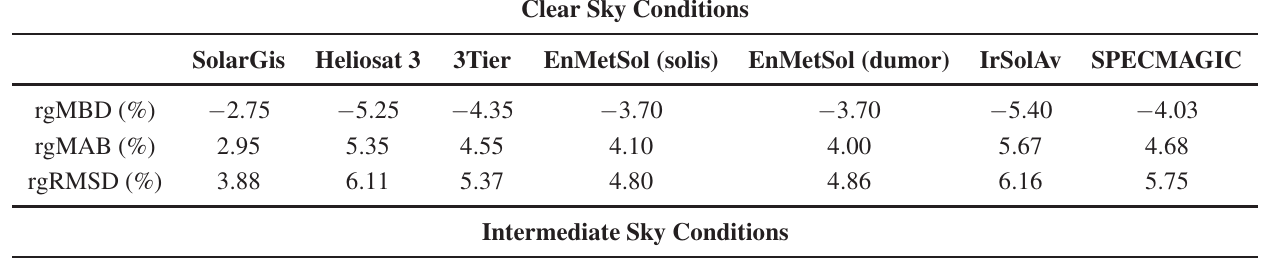
Table 7. General statistics for the validation of global horizontal irradiance estimation for clear, intermediate and overcast sky situations’ [35]. The results for the present work are given as the last column for comparison. Clear Sky Conditions SolarGis Heliosat 3 3Tier EnMetSol (solis) EnMetSol (dumor) IrSolAv SPECMAGIC